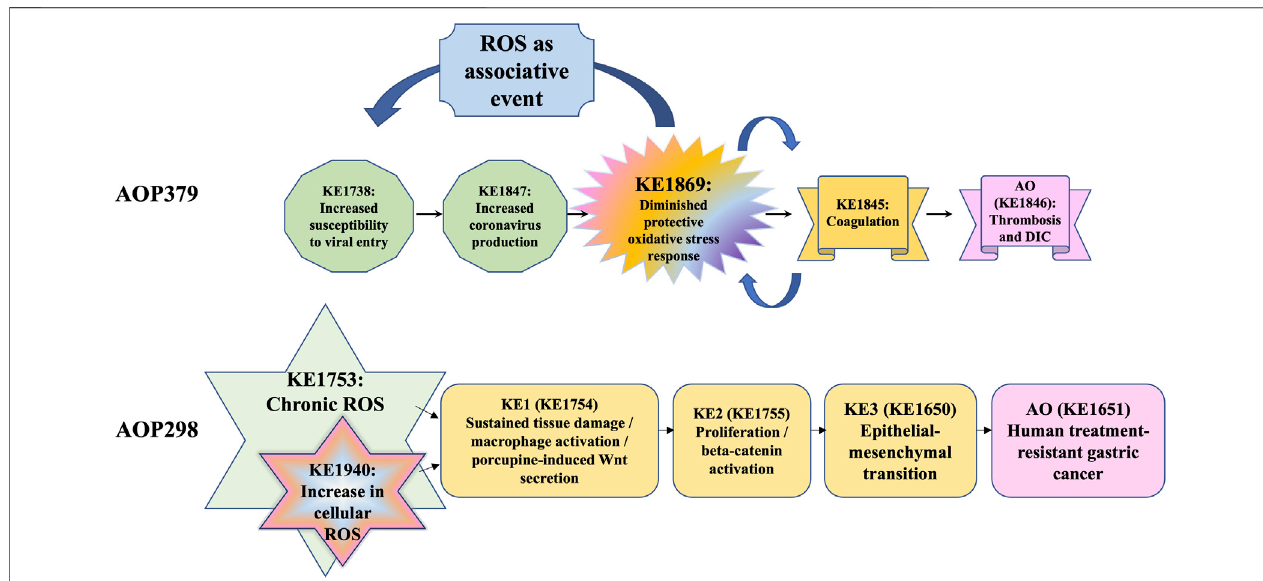
FIGURE 1 | Examples for the concept of the ROS as a KE and associative event in AOPs *DIC: disseminated intravascular coagulation.